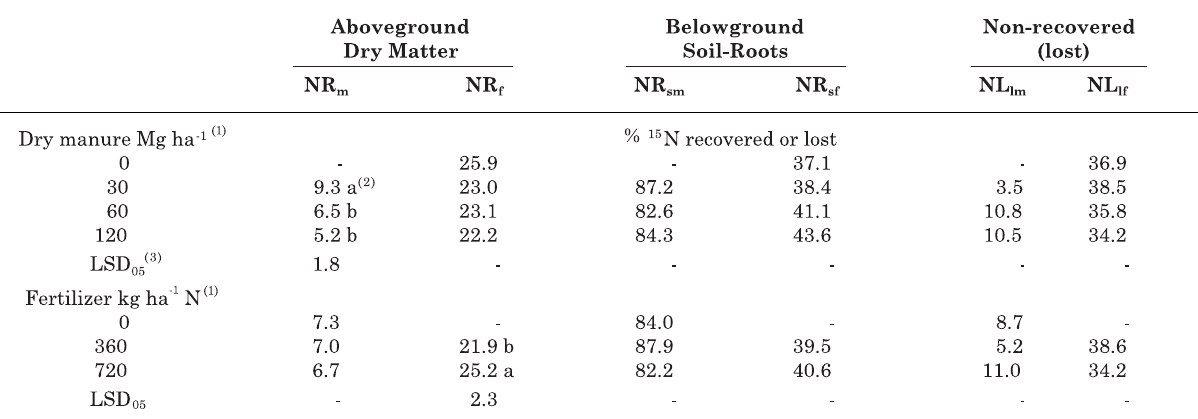
Table 4. Total N recovered from manure and fertilizer in the aboveground dry matter (NR recovered belowground (soil and roots) (NR ) after three extraction cycles with annual crops (annual ryegrass-sudan grass-annual NL lf